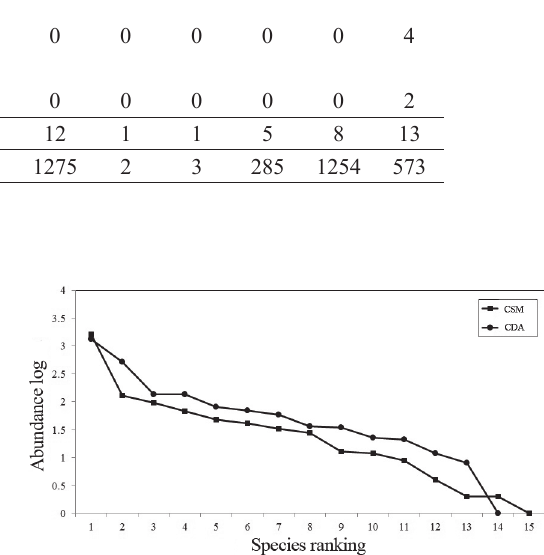
Figure 3 - Whittaker’s Graph based on decrescent values of the abundance logarhythm of anuran species recorded in fragments of the Mesophytic Semideciduous Forest, between September 2011 and March 2012.